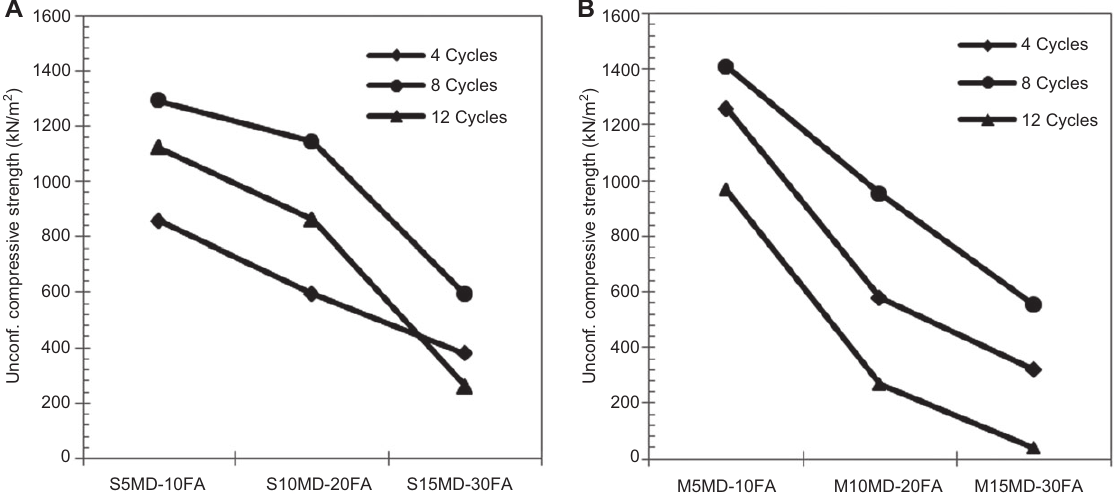
Figure 2 Unconfined compressive strength after F-T cycles. (A) Specimens with SPE. (B) Specimens with